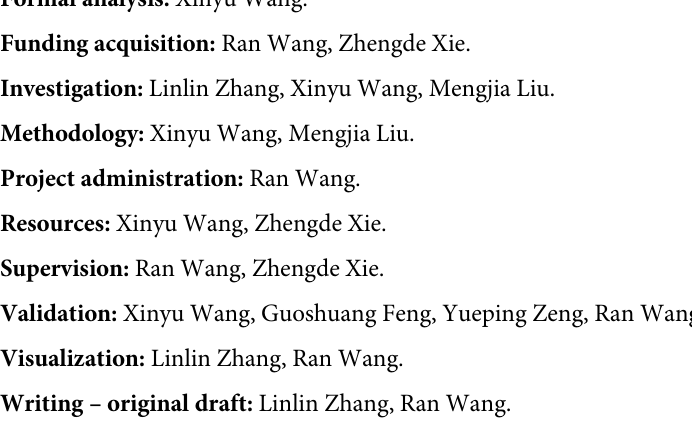
S2 Fig. Hospitalization rate and number of congenital CMV infections (n = 132), Decem- ber 2015–December 2020. M (n): number of monthly hospitalizations, Y (n): number of yearly